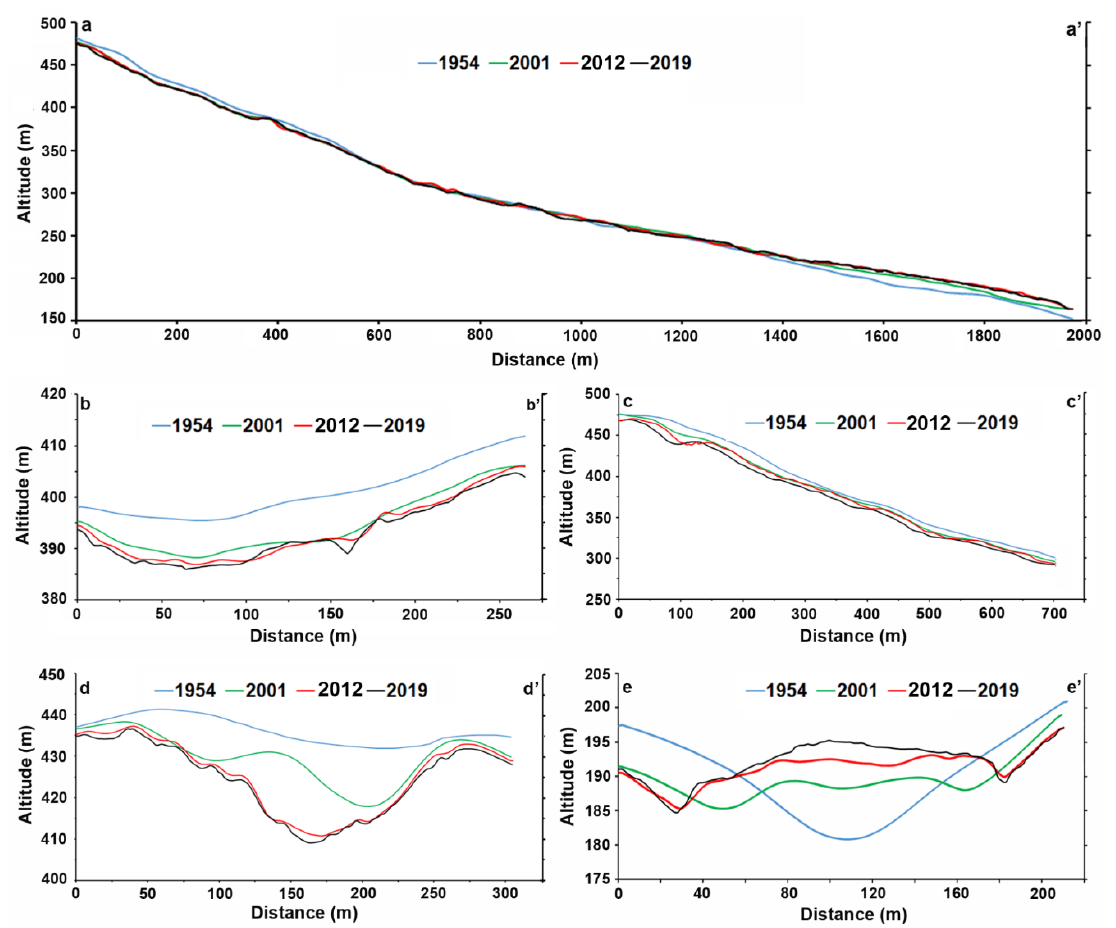
Figure 10. Examples of longitudinal and transverse cross section profiles along the Vomice earthflow. Location of the cross-section tracks are show in Figure 9.